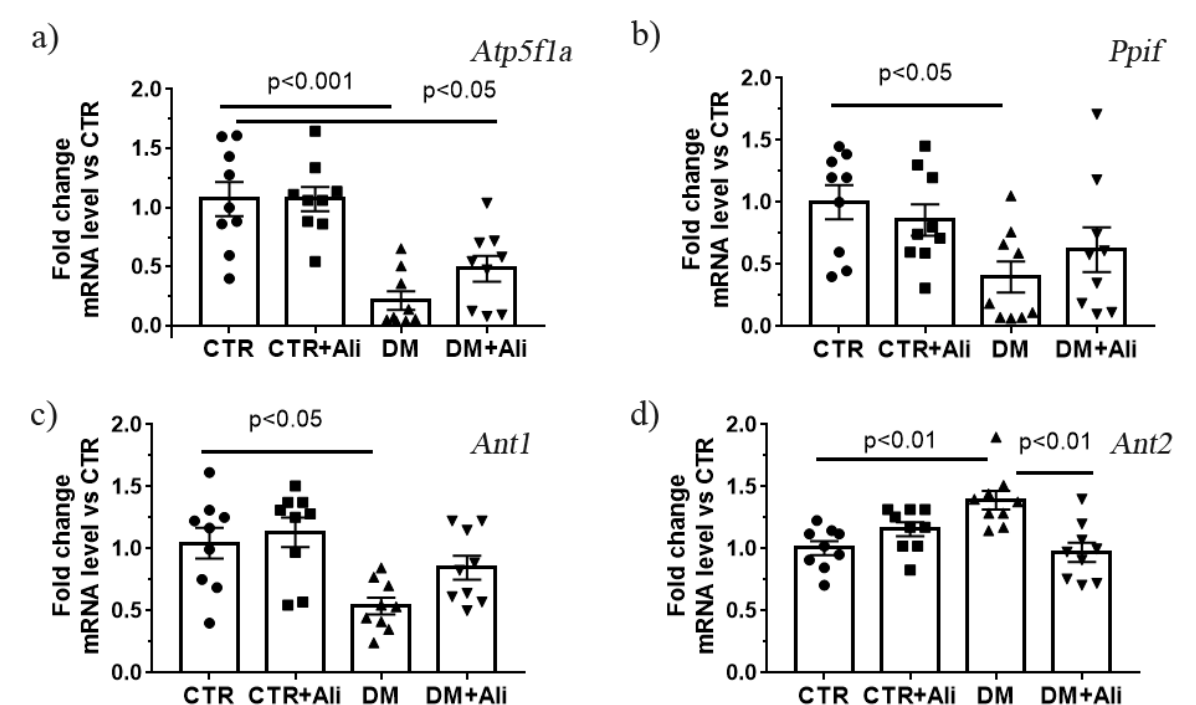
Figure 5. The relative mRNA levels of Atp5f1a ( a ), Ppif ( b ), Ant1 ( c ), and Ant2 ( d ) in the skeletal muscles of experimental animals. The values are given as mean ± SEM ( n = 9).